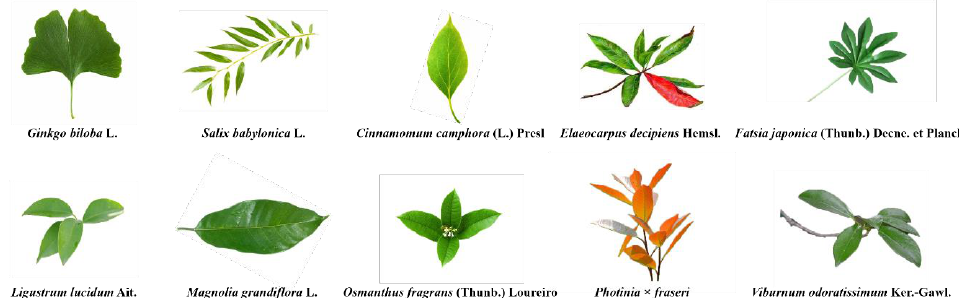
Figure 1. Leaves and shoots of the 10 tree species included in the